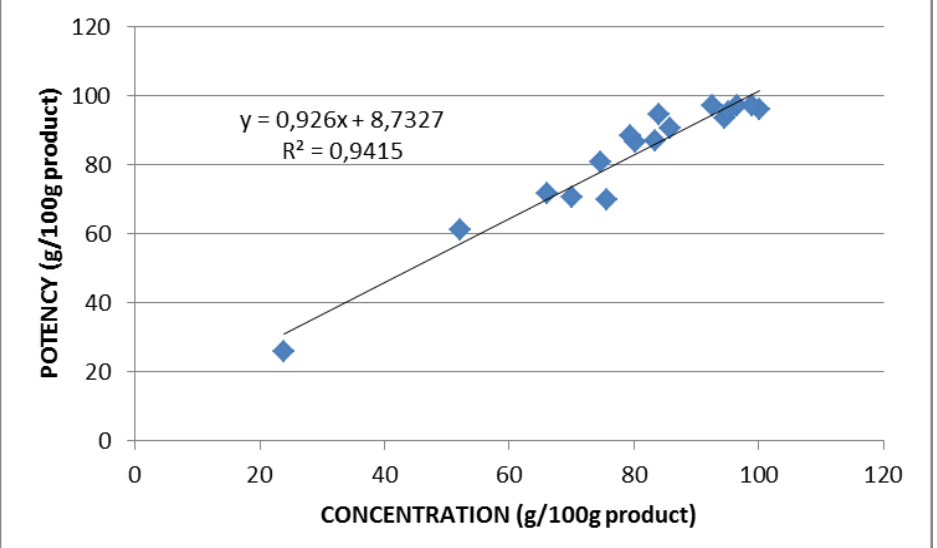
Figure 2. Correlation between potency (microbiological activity) and concentration (HPLC) of lysozyme in commercial